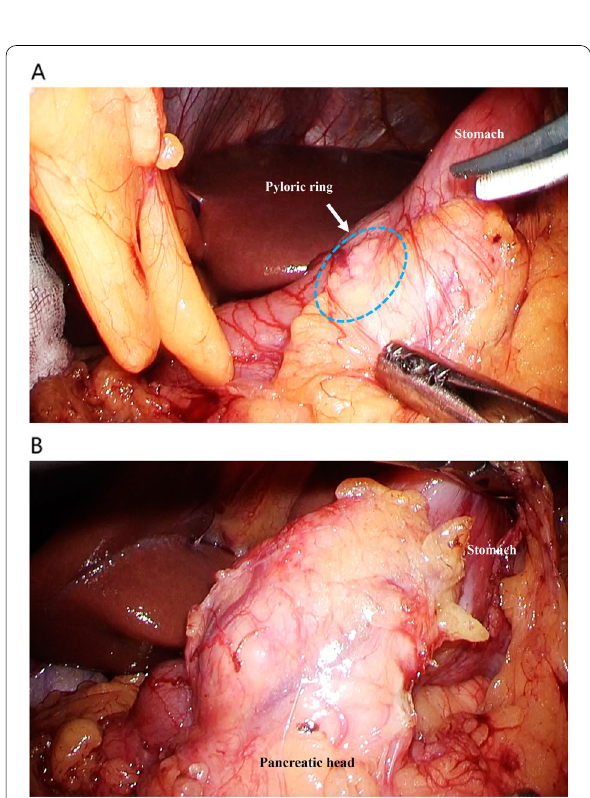
Fig. 4 Intraoperative findings. A Intraoperative findings showed a broad extension of the pancreatic parenchyma from the pancreatic head to the anterior gastric side of the gastric pylorus to the duodenal bulb. Slight inflammatory changes were observed around the pyloric ring (blue dotted circle). B The great omentum was resected to confirm the continuity between the pancreatic head and the pancreatic tissue extending to the pyloric